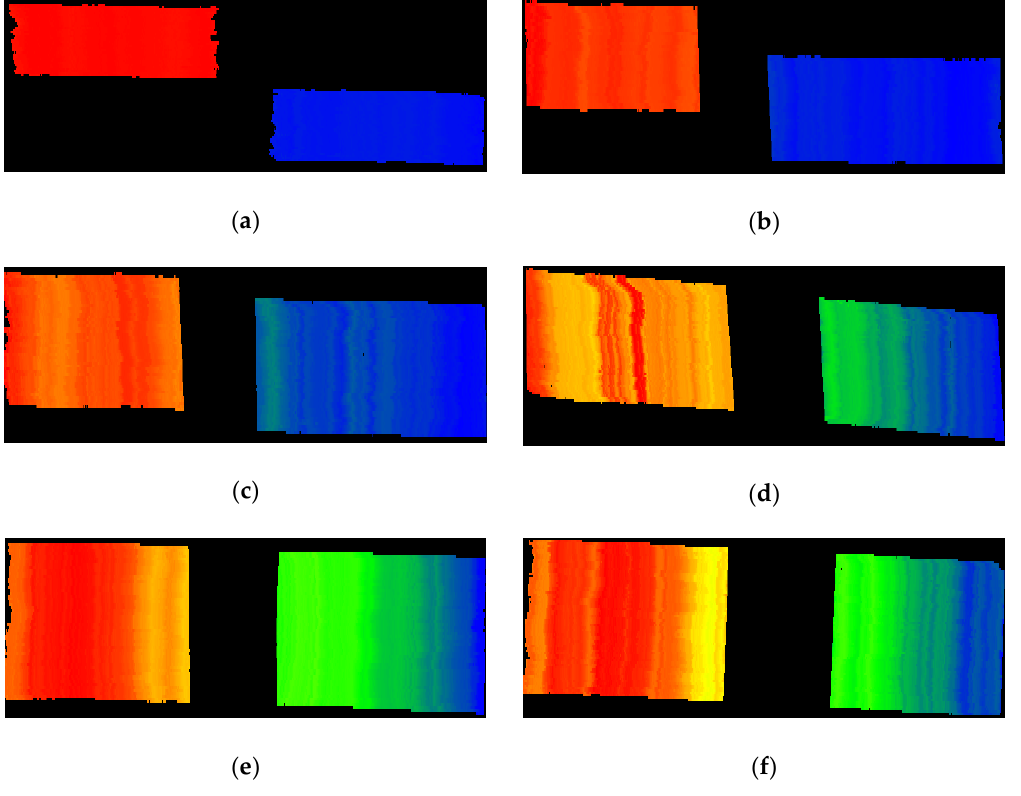
Figure 4. The measurement results of the step masters shown as depth maps after smoothing and filtering. The depth display of ( a ) 300 ± 0.2 µm, ( b ) 100 ± 0.2 µm, ( c ) 50 ± 0.2 µm, ( d ) 20 ± 0.2